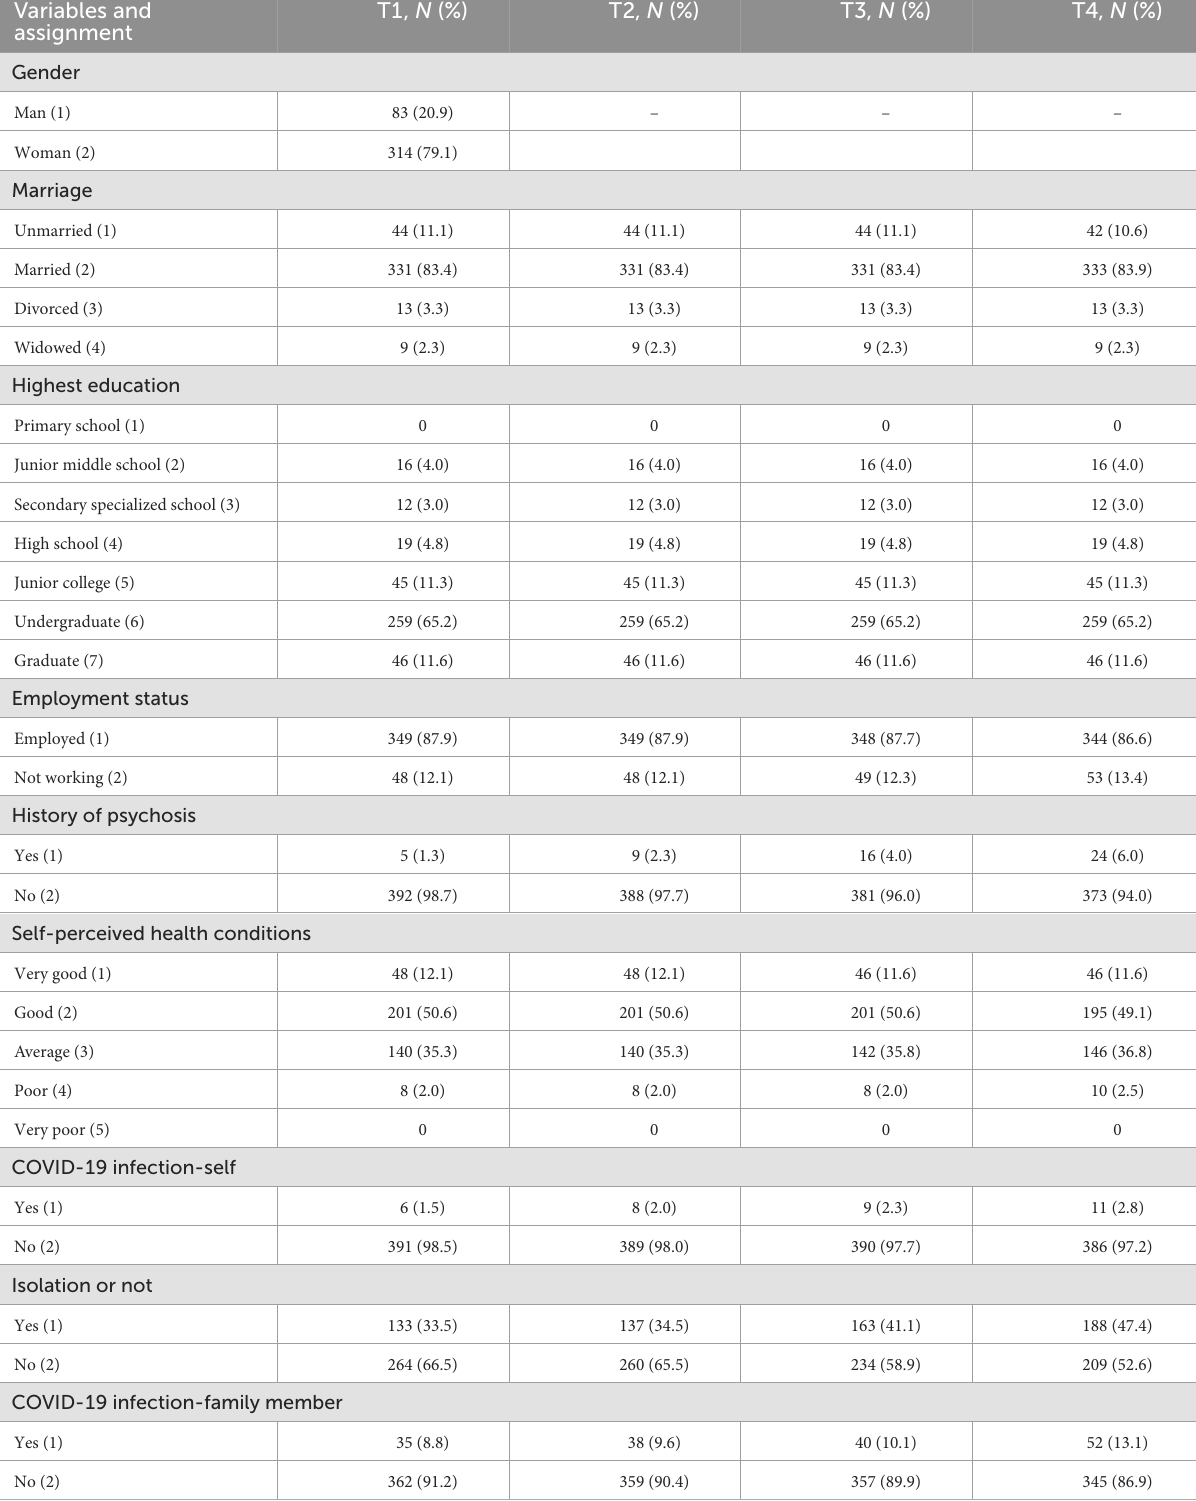
TABLE 1 Demographic and related pandemic information distribution of participants at different time points ( n =